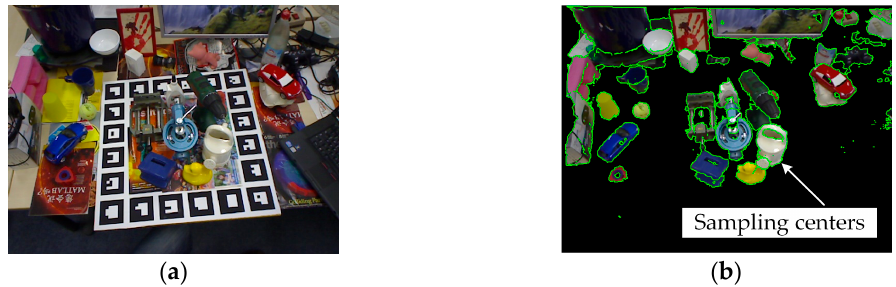
Figure 2. Illustration of sampling center extraction: ( a ) original image; ( b ) scene image overlaid with sampling centers (colored in green).